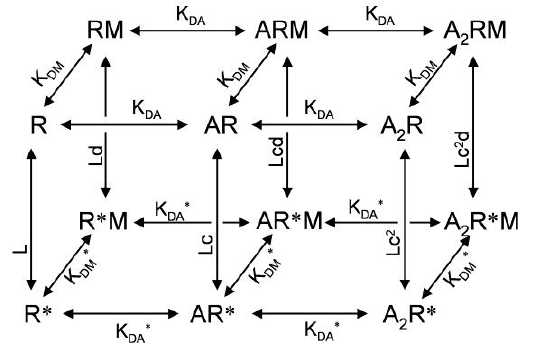
Figure 3. Kinetic scheme for allosteric activation and modulation mechanisms (adapted from [35]). Front is the conventional MWC model. The only difference is that K and DA K * are used to represent agonist binding affinity. Allosteric modulator (M) bound states DA are shown at the back of the figure, with K and K * describing two different affinities DM DM for the modulator in resting or activated states. L is the ratio between R and R*. c is the ratio between K * and K . d is the ratio between K and K DA DA DM DM